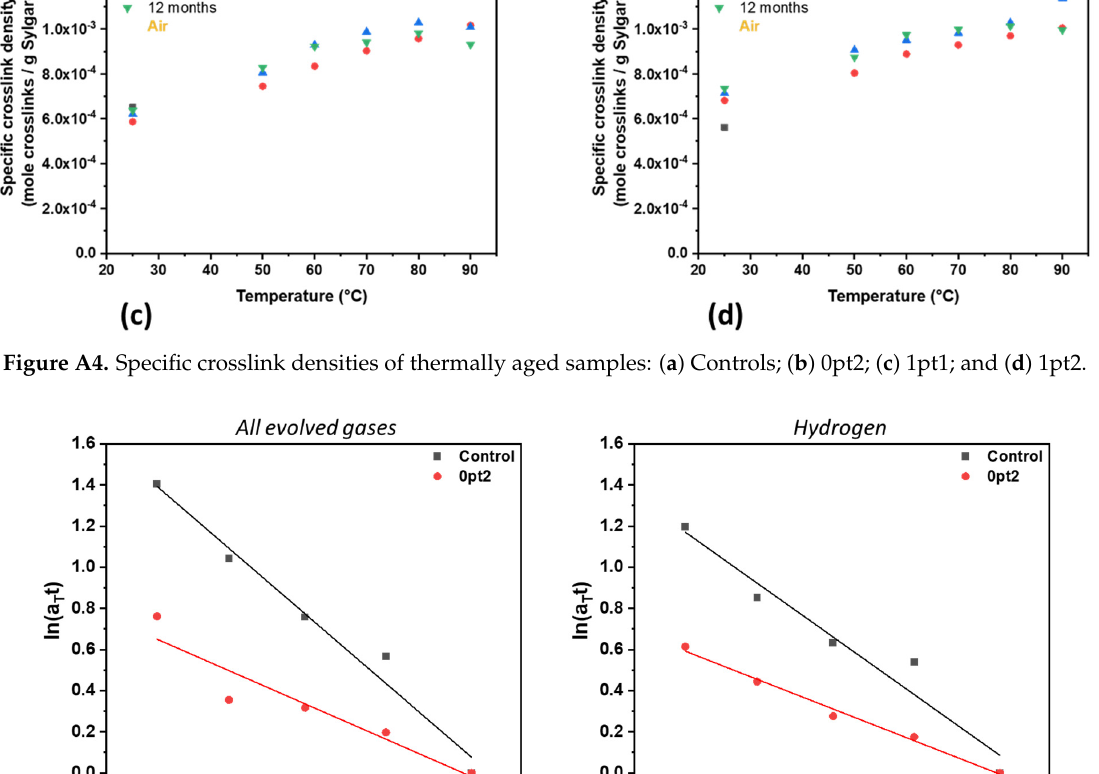
Figure A5. Validity of the TTS model for mass spectrometry data, where ln(cid:4666)a (cid:2904) t(cid:4667) and 1 T(cid:3415) display a linear relationship for ( a ) all evolved gases and ( b ) hydrogen.